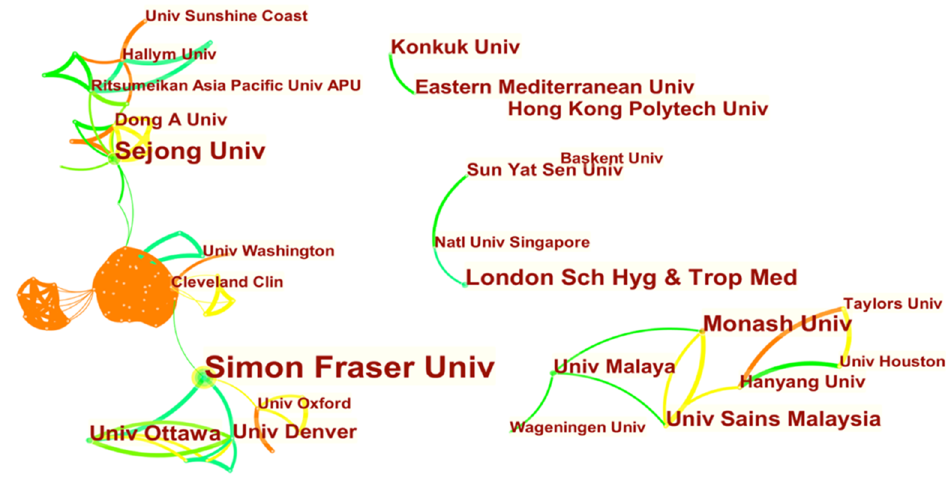
Int. J. Environ. Res. Public Health 2021 , 18 , 10875 Figure 4. Institutions of authors.